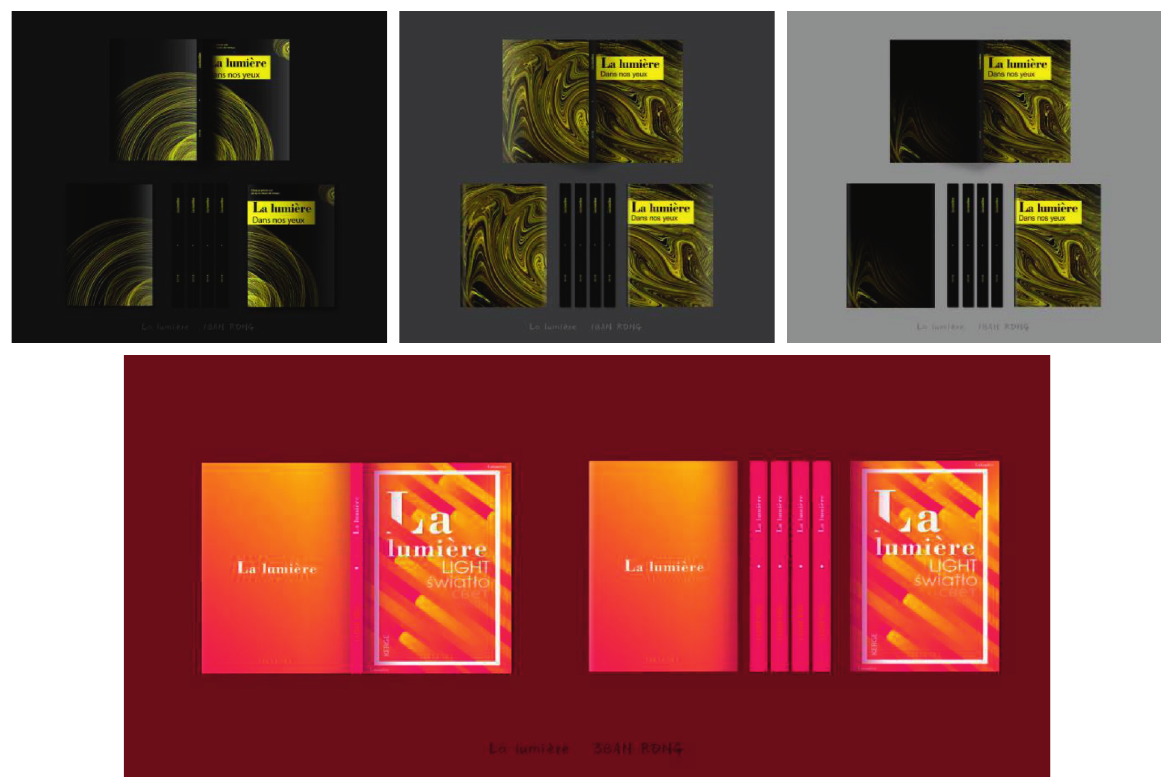
Figure 1: Different design options for book covers.